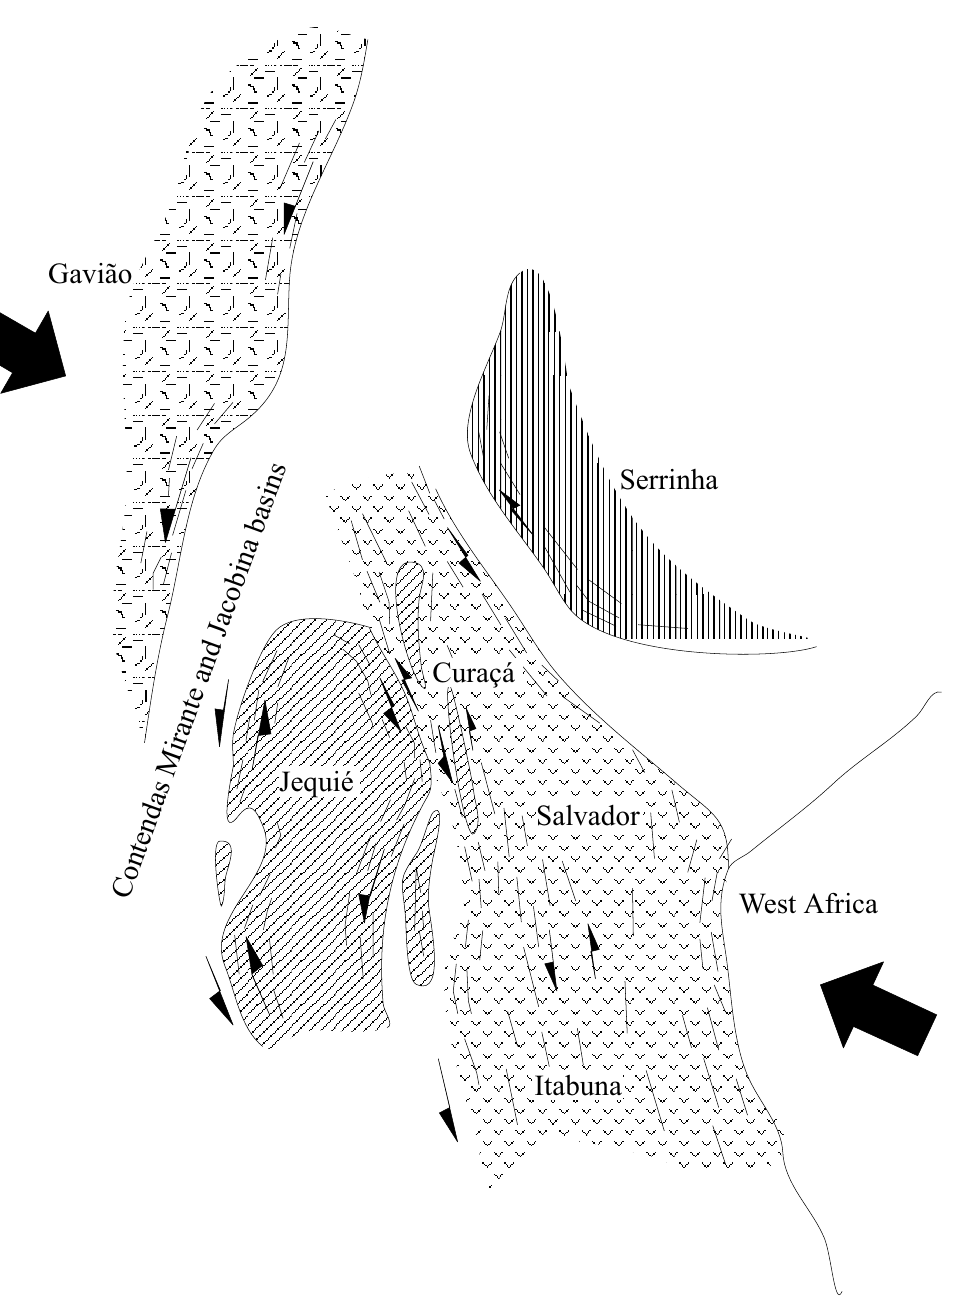
Fig. 4 – Relative position of theArchean blocks prior to Paleoproterozoic collision. The Jacobina Group and the top of the Contendas- Mirante Basin (Areião Formation), both of Paleoproterozoic age, are shown.